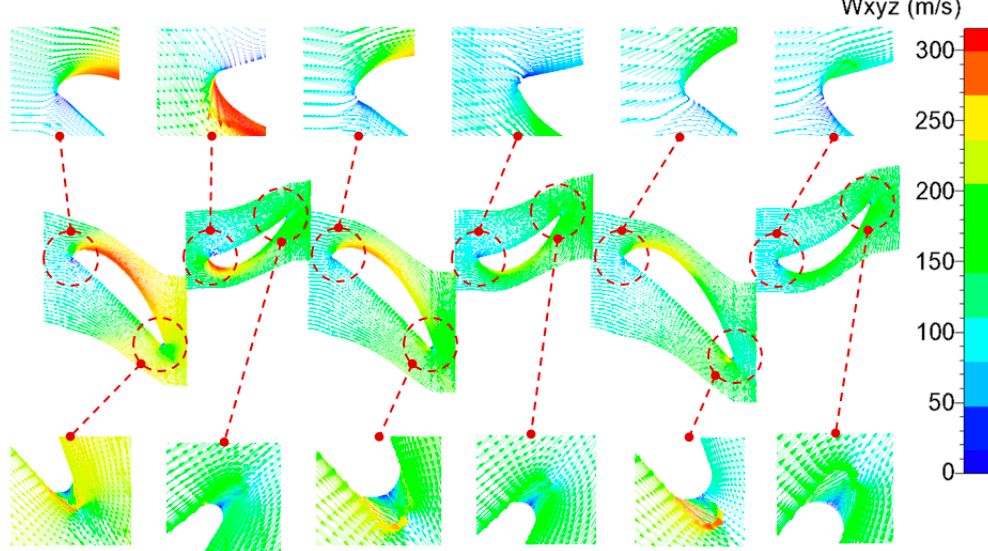
Figure 5. The distribution of the streamline on the 50% blade height section.